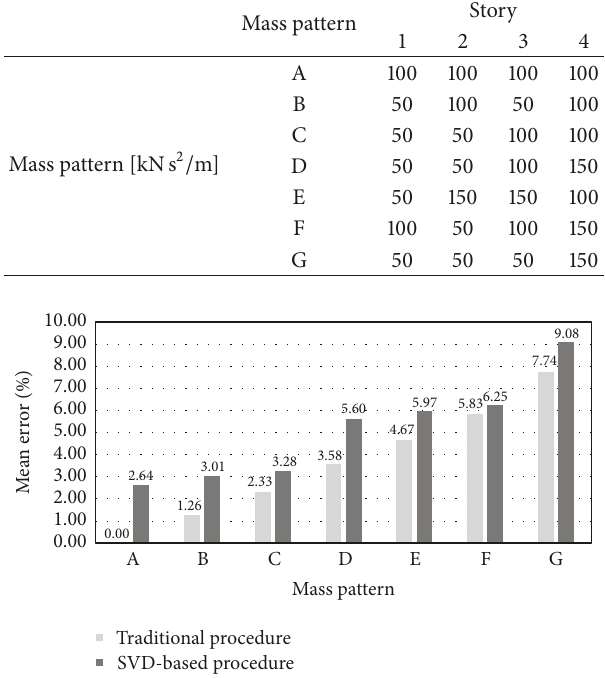
Table 10: Damage indices estimated by modal vectors-based proce- dure in case of complete (on the left) and partial identification (on the right, by using only the first vector) on the shear-type frame.